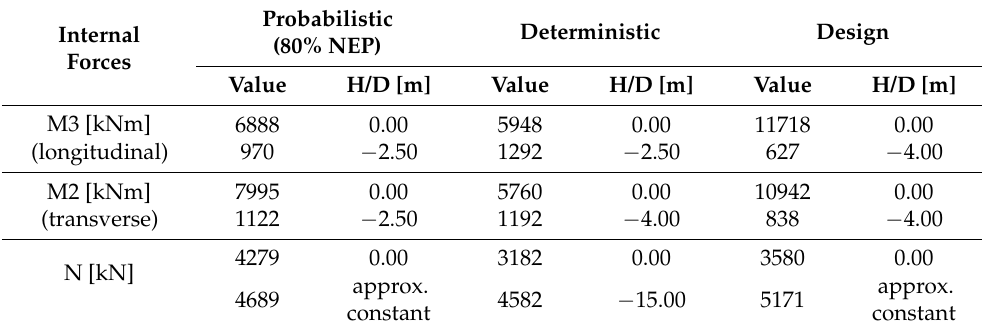
Table 5 sums up the differences in internal forces between the three models as follows: Table 5. Main differences of internal